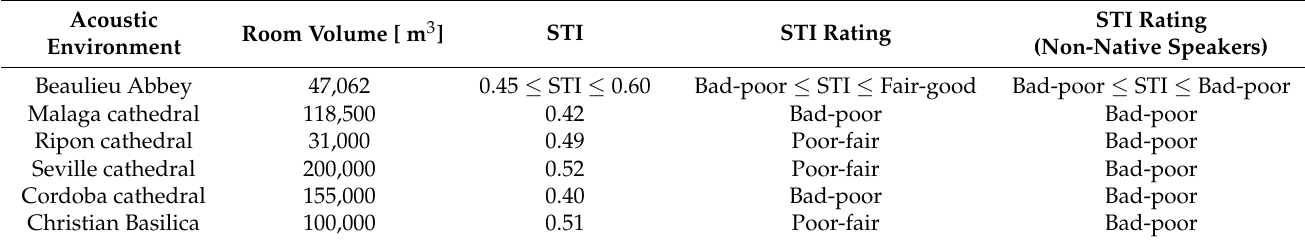
Table 9. Spatially averaged STI